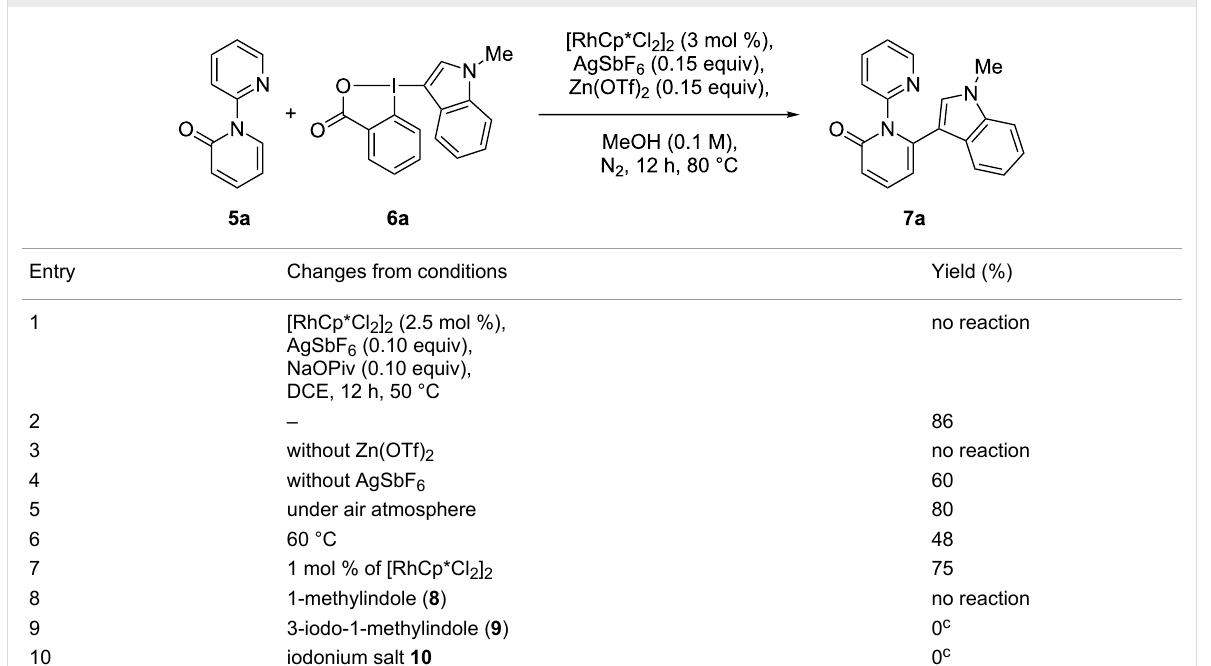
Table 1: Optimization of the C–H heteroarylation a,b